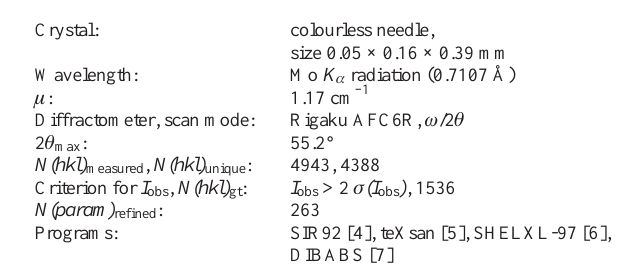
orientation of the C14 and C20 ester groups. The four carbonyl groups lie to one side of the molecule and the two epoxides to the other. Table 1. Data collection and handling.